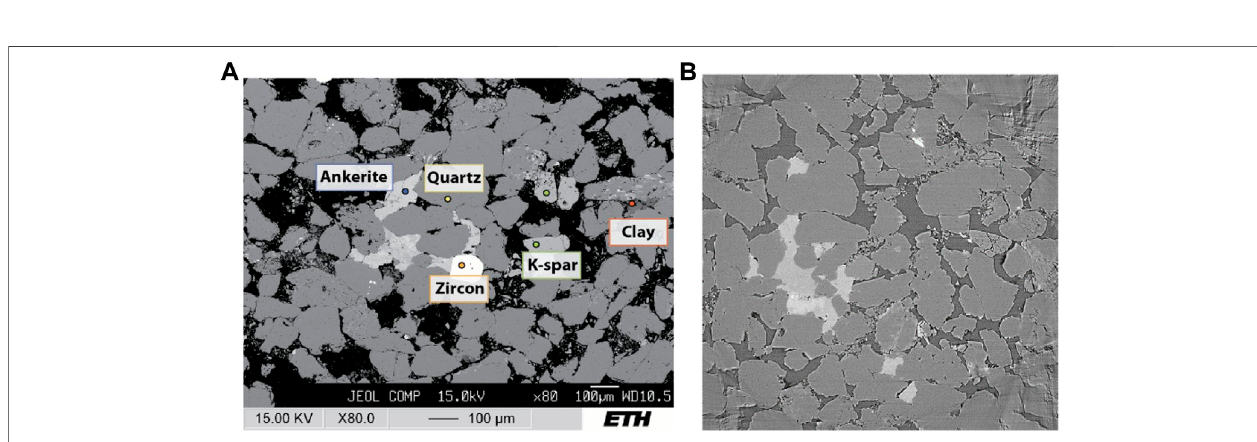
FIGURE 11 | (A) Different minerals of Berea sandstone detected in a Scanning electron microscopy and (B) μ CT image of Berea sandstone.